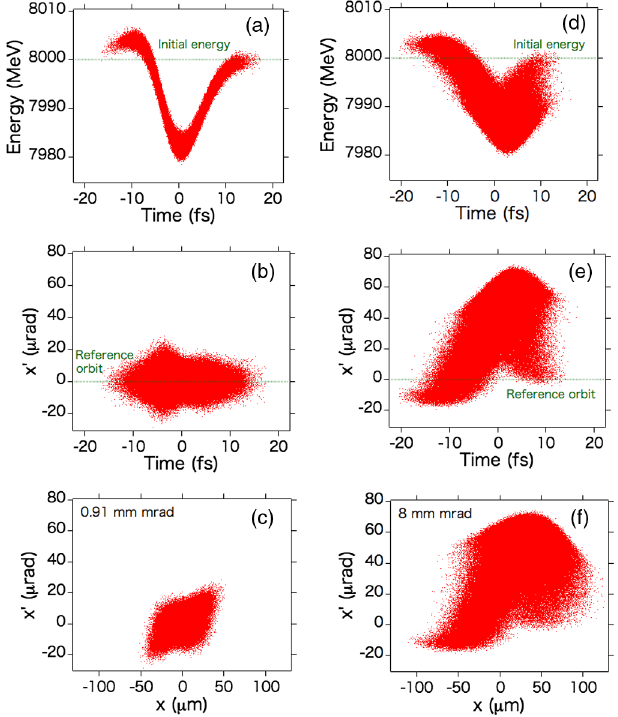
FIG. 4. Phase space distributions of the electron bunch after the BL2 dogleg. (a – c) and (d – f) are calculated for the new beam optics and for the old beam optics, respectively. The initial conditions of the electron bunch are 8 GeV, 10 kA, 10 fs (FWHM) and 0.8 mm